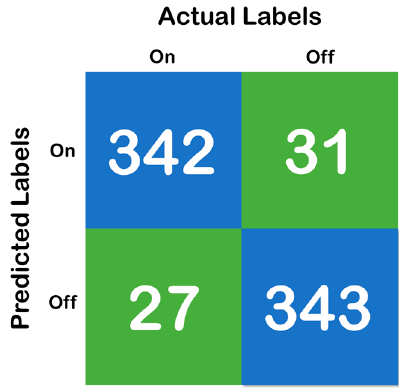
Figure 7. Confusion matrix of the cross-validation, where the blue color represent the True Prediction and Green represents the Mispredictions.